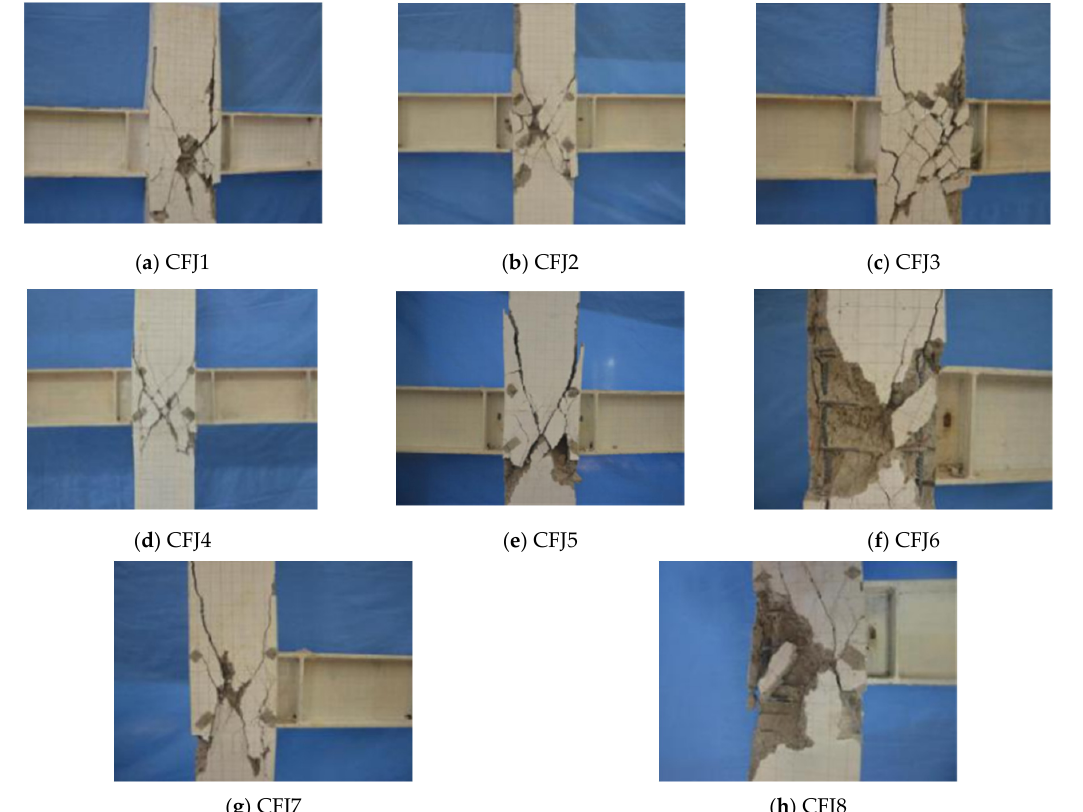
Figure 3. Failure modes of joints.